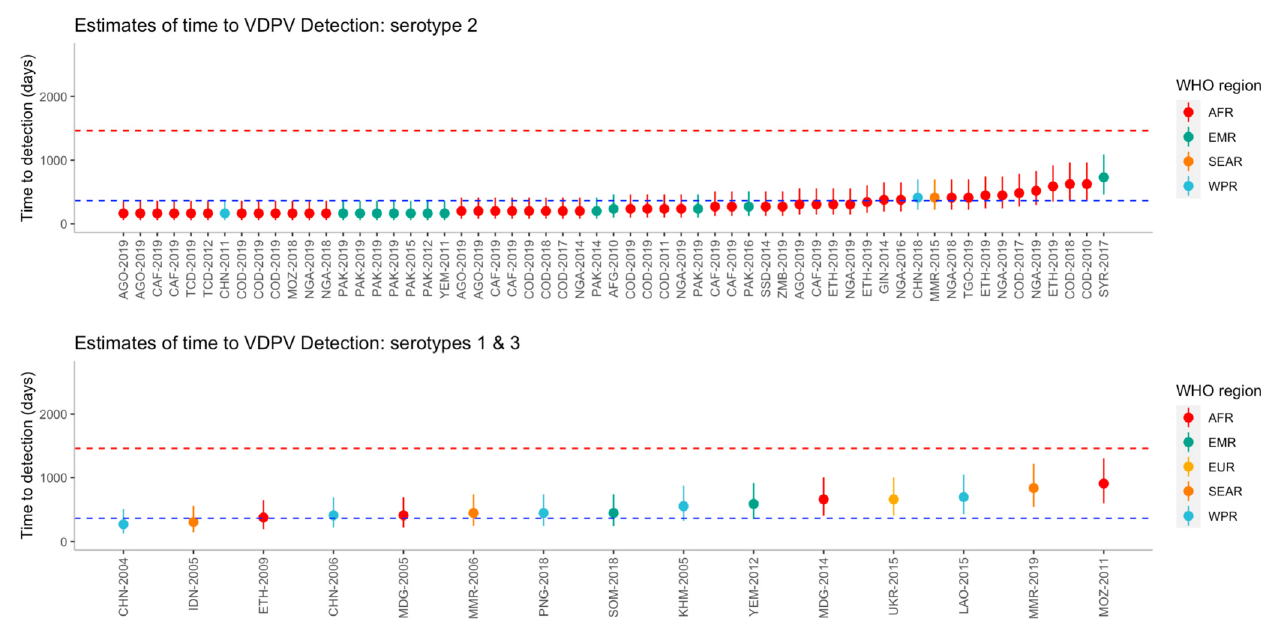
Figure 3. Estimated time to detection of each outbreak from the reported number of nucleotide differences from the Sabin strain, by serotype and region. Outbreaks are ordered on the x-axis by increasing time to detection, where uncertainty in the estimates are shown using 95% uncertainty intervals. Dashed lines represent one year (blue) and four years (red). Country names along the x-axis have been abbreviated using a country’s corresponding United Nations ISO 3166-1 alpha-3 code and year of first detection.